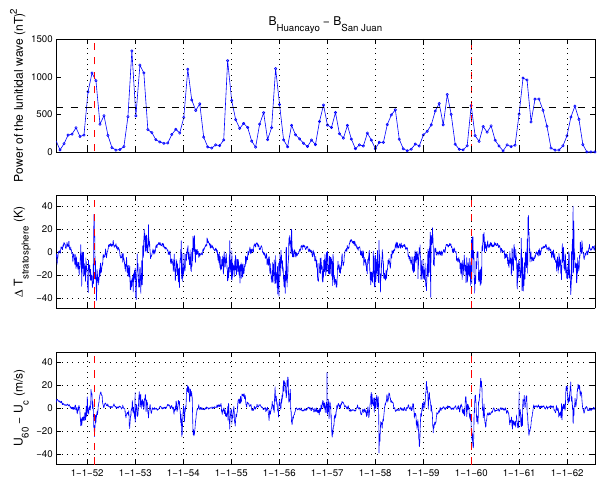
Figure 3. The top frame presents the wave power of the lunar tide derived from the Huancayo–San Juan pair for the years 1952–1962. The middle frame shows the zonal mean temperature gradient for the same period. The bottom frame shows the difference between the zonal mean zonal wind (U 60 ) at 60 ◦ N and 10hPa from the cli- matological mean (U C ) . The red lines mark the days of SSW (peak warming) events and the black dashed line in the top panel denotes the threshold level calculated for classifying SSW and non-SSW